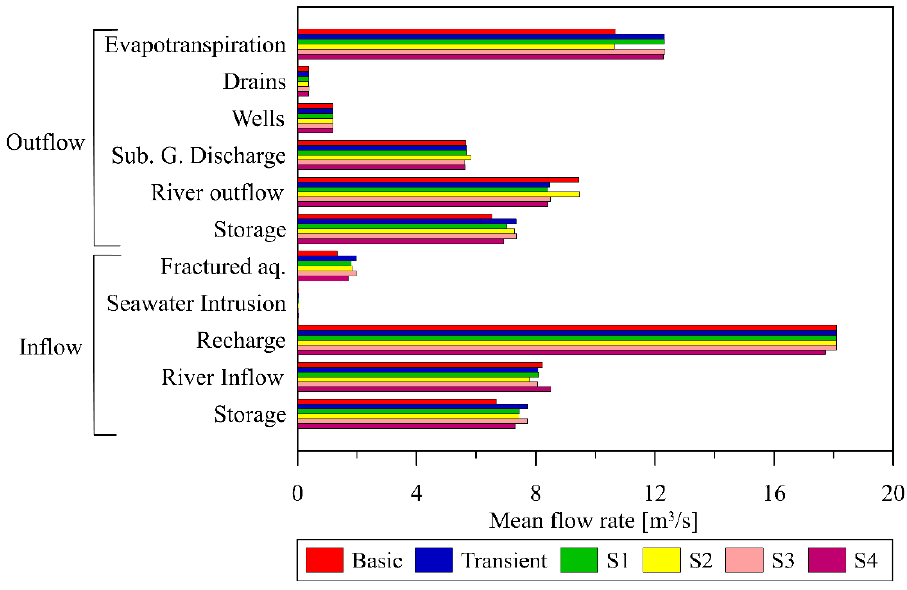
Figure 6. Comparison of the average flow rates and storage over the simulation time between: Basic, Transient, S1, S2, S3, and S4 simulations.